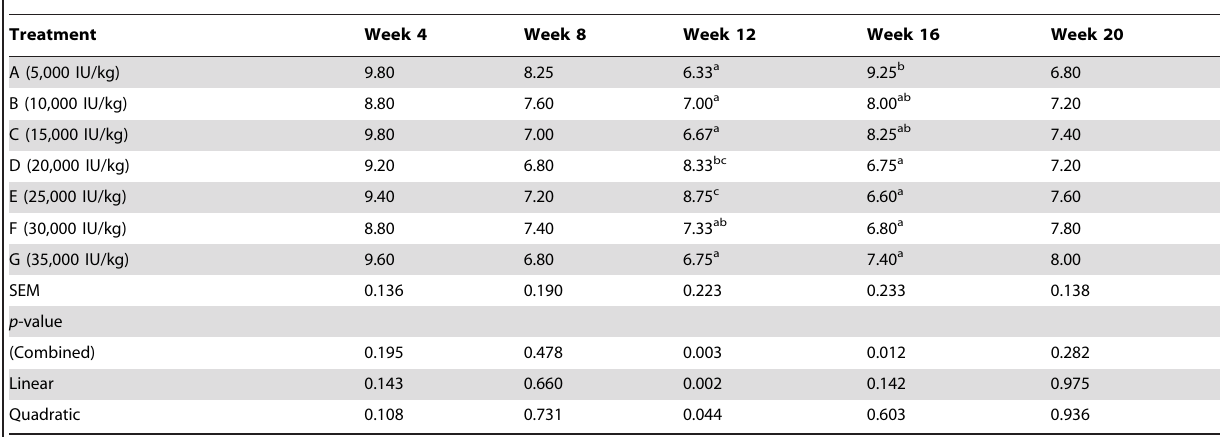
Table 8. Antibody response to Newcastle disease virus